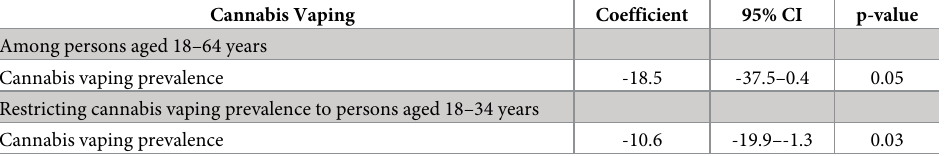
Table 2. Table showing the association between state-level cannabis vaping prevalence and EVALI cases per mil- lion population.